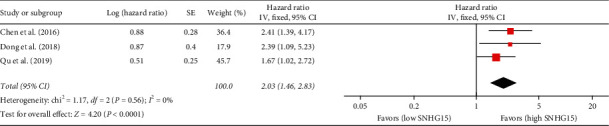
Forest plot for association between SNHG15 expression and RFS.